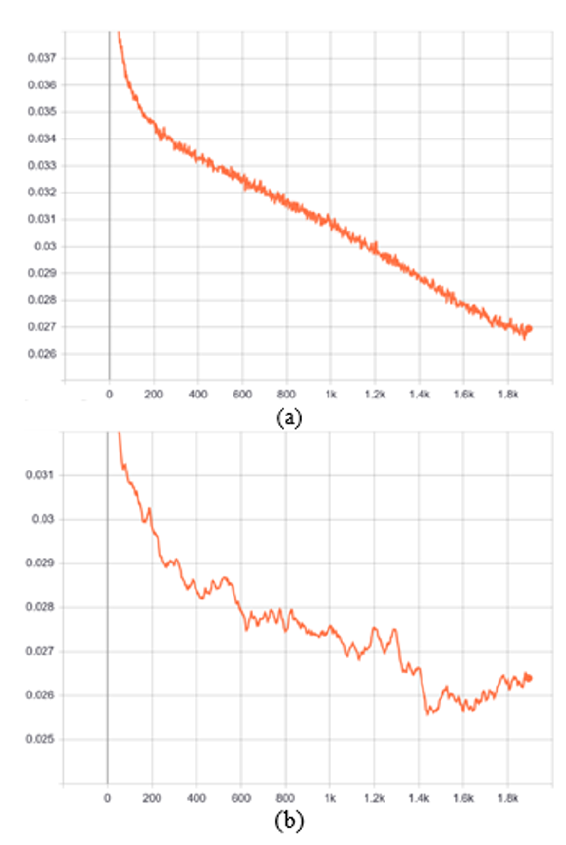
Figure 4: A plot to show GIoU loss during training of the YOLOv5l model on training and validation samples of Thai-Vehicle-Classification-Dataset. (a) On training samples. (b) On validation samples. with relatively lower OA from 90% to 94%. The